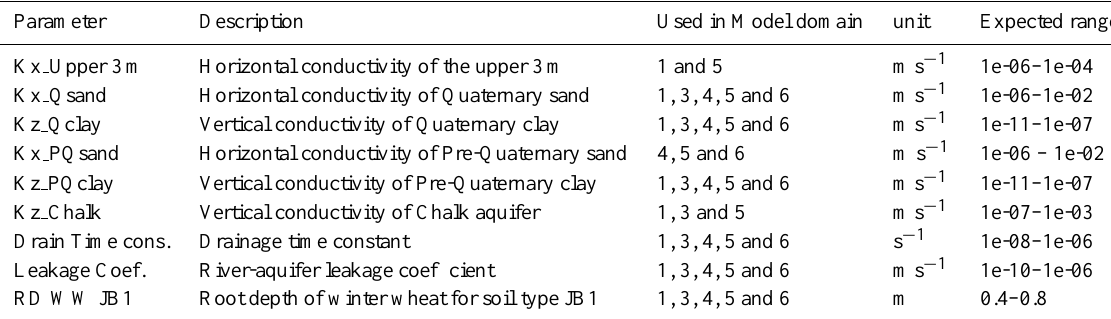
Table 2. Calibration parameters, expected ranges are adapted from Henriksen et al. (2003). Parameter Description Used in Model domain unit Expected range Kx Upper 3m Horizontal conductivity of the upper 3m 1 and 5 ms − 1 1e-06–1e-04 Kx Qsand Horizontal conductivity of Quaternary sand 1, 3, 4, 5 and 6 ms − 1 1e-06–1e-02 Kz Qclay Vertical conductivity of Quaternary clay 1, 3, 4, 5 and 6 ms − 1 1e-11–1e-07 Kx PQsand Horizontal conductivity of Pre-Quaternary sand 4, 5 and 6 m s − 1 1e-06 – 1e-02 Kz PQclay Vertical conductivity of Pre-Quaternary clay 1, 3, 4, 5 and 6 ms − 1 1e-11–1e-07 Kz Chalk Vertical conductivity of Chalk aquifer 1, 3 and 5 ms − 1 1e-07–1e-03 Drain Time cons. Drainage time constant 1, 3, 4, 5 and 6 s − 1 1e-08–1e-06 Leakage Coef. River-aquifer leakage coefficient 1, 3, 4, 5 and 6 ms − 1 1e-10–1e-06 RD WW JB1 Root depth of winter wheat for soil type JB1 1, 3, 4, 5 and